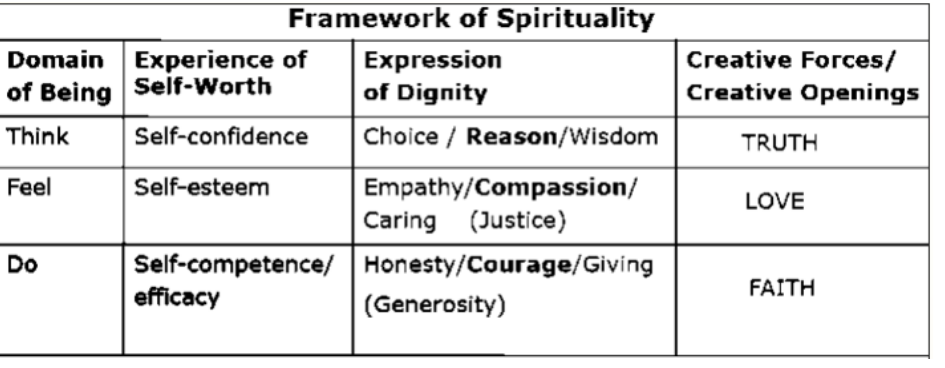
Figure 1. Each of the elements of this framework is described in the text. This illustrates the full FOS, including the expansion of the expression of dignity socially as wisdom, justice, and generosity. The expansion to the Creative Forces/Creative Openings occurs as the spiritual core ( 𝜮 ) is opened.